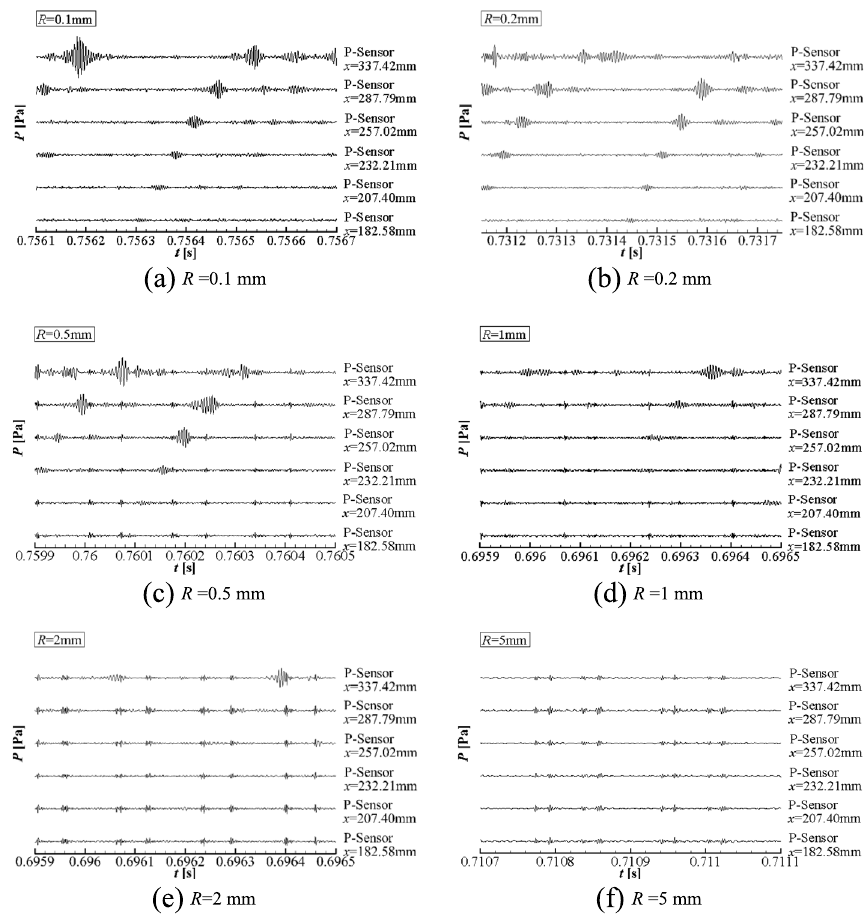
Fig. 8 Time transient of PCB sensors with Re unit